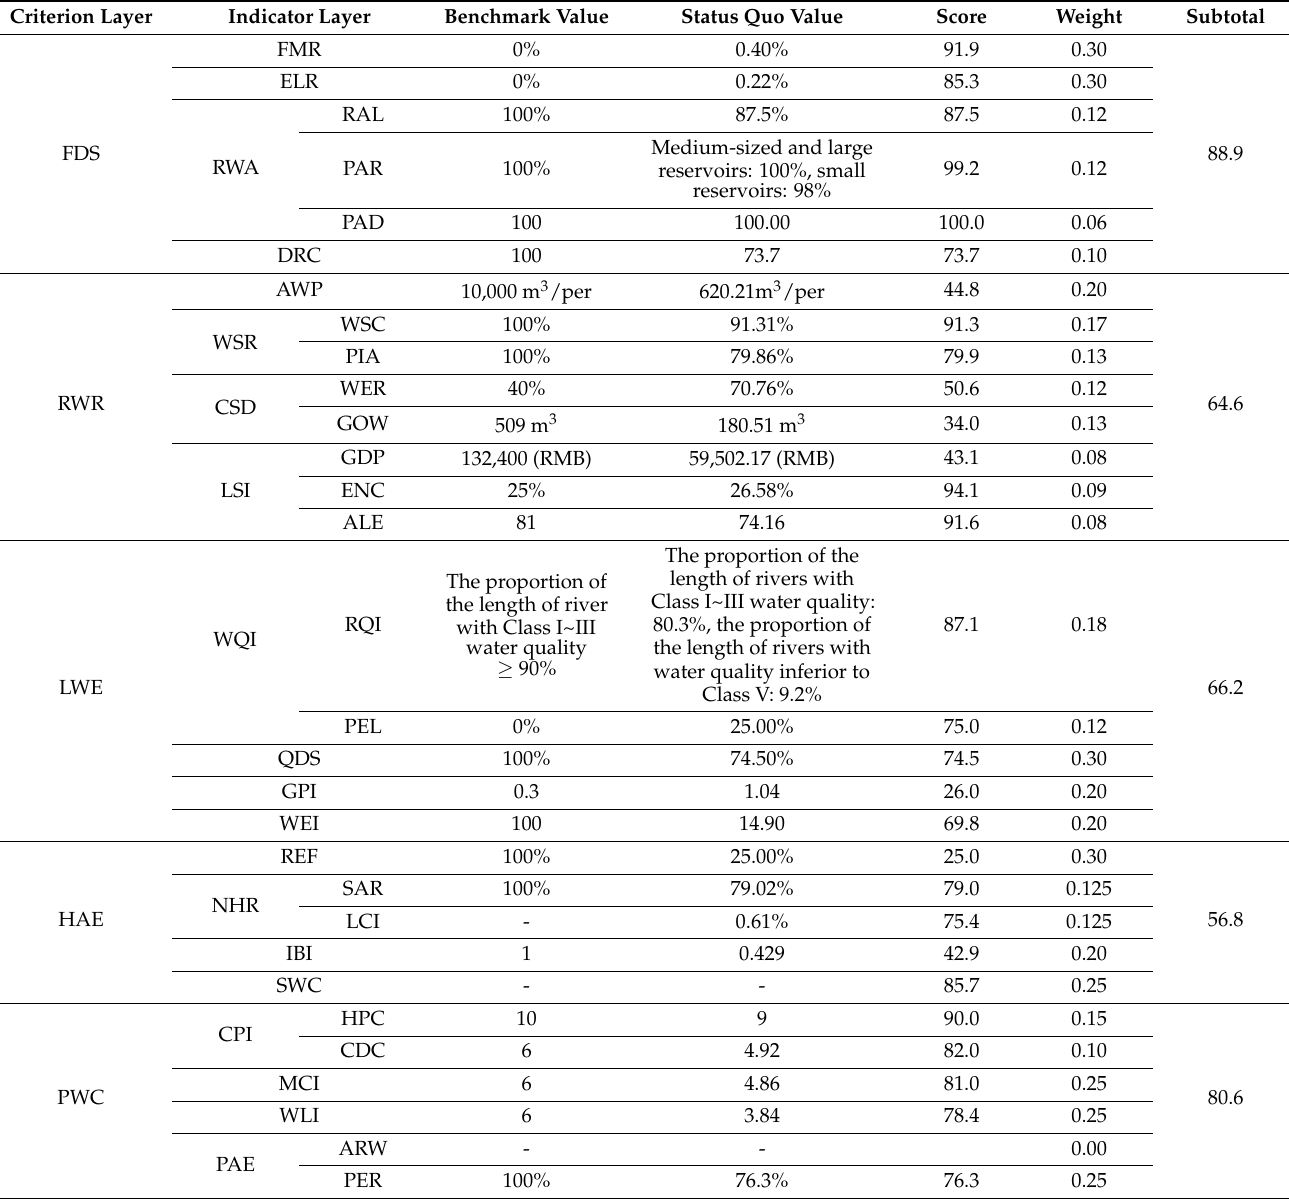
Table 8. RHI evaluation results for the Yellow River